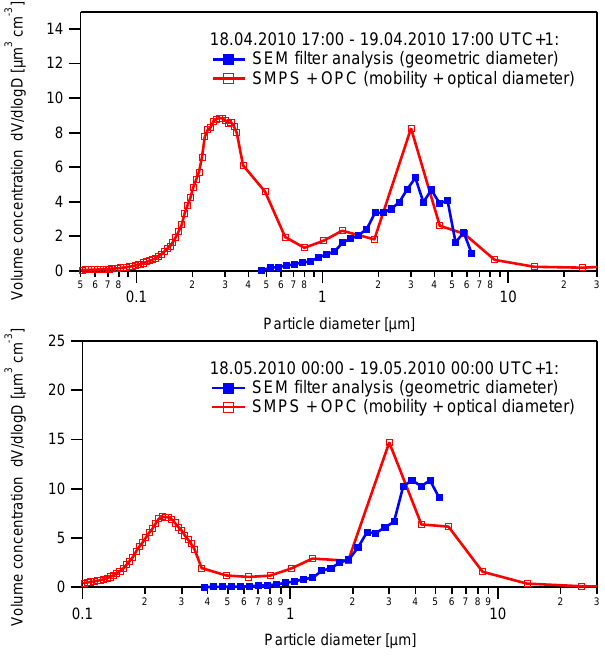
Fig. 9. Closure between the volume distribution measured by SMPS and OPC and the volume distribution estimated by SEM analysis of 3000 ash particles. A refractive index of 1.54+0.005i ( λ = 780nm) was used to correct the OPC volume distributions. The accumula- tion mode particles were not accessible for SEM analysis (see text). The uncertainties of each of the methods was in the range of the differences between the shown distributions.